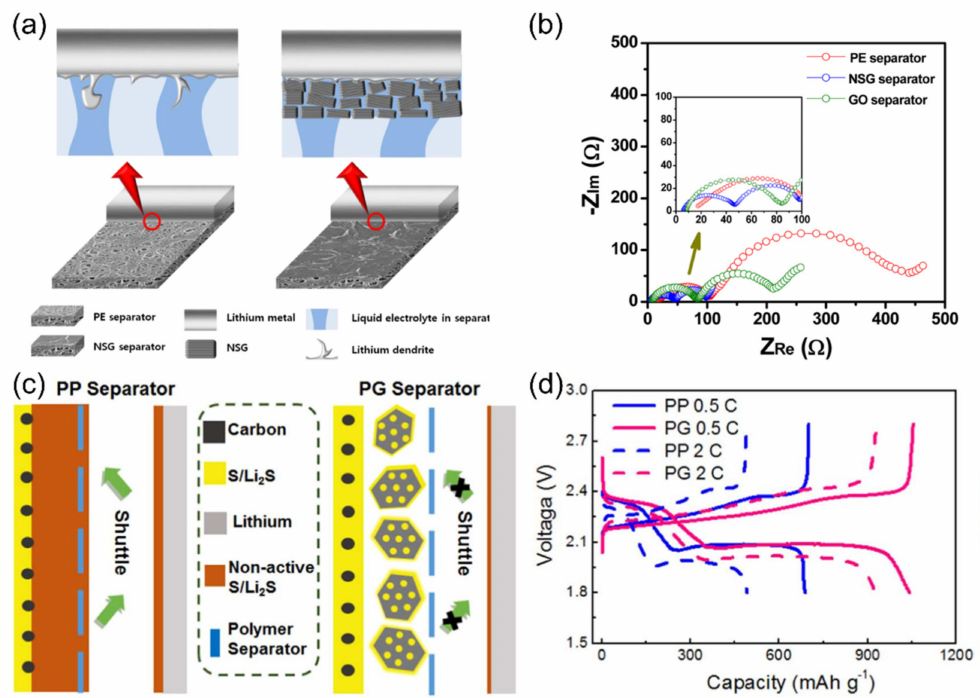
Figure 14. ( a ) Schematic drawing of dendrite growth on the lithium metal electrodes with the PE separator (left) and nitrogen and sulfur co-doped graphene-coated PE separator (right). ( b ) AC impedance spectra of the Li metal cells assembled with different separators after 200 cycles. Reproduced with permission from ref. [165]. Copyright 2015, ACS Publications. ( c ) Schematic drawing of reaction difference between the PP and porous graphene (PG) separators at the sulfur cathode/separator interface. ( d ) Galvanostatic charge–discharge profiles at 0.5 C and 2 C. Reproduced with permission from ref. [167]. Copyright 2016,